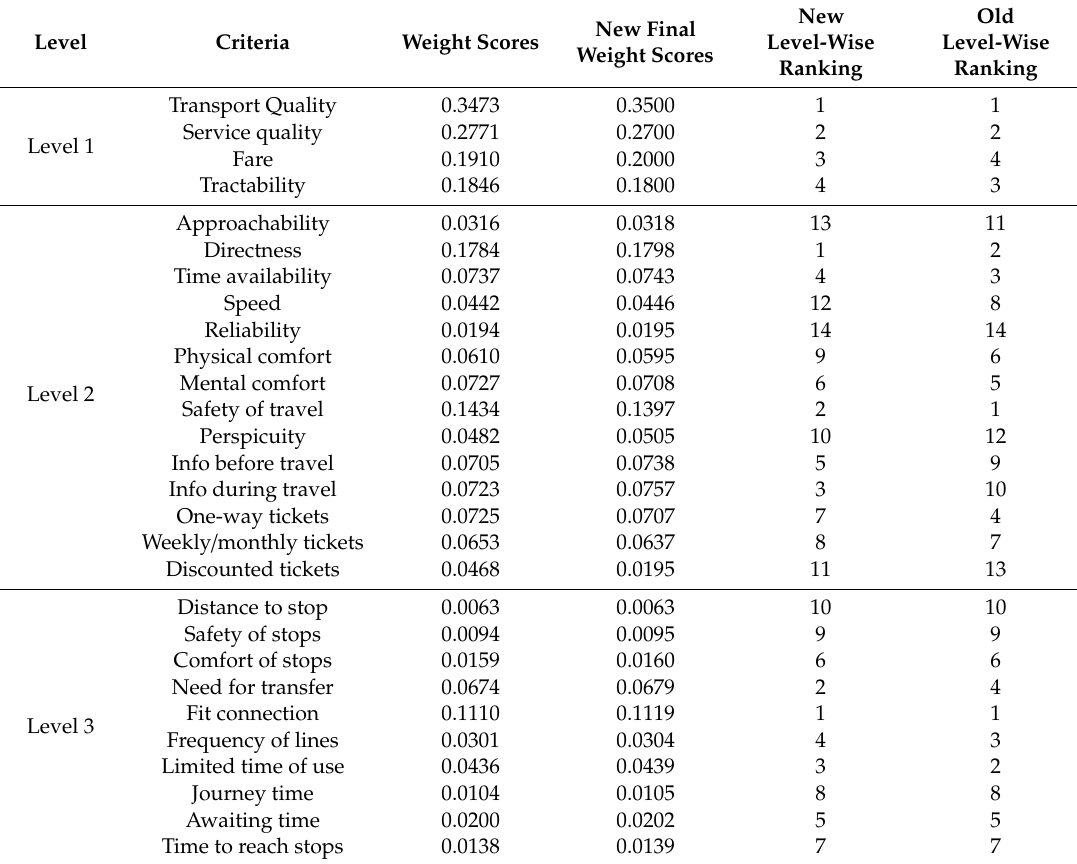
Table 12. Weight scores and ranking after the sensitivity check for the municipal o ffi cials group.